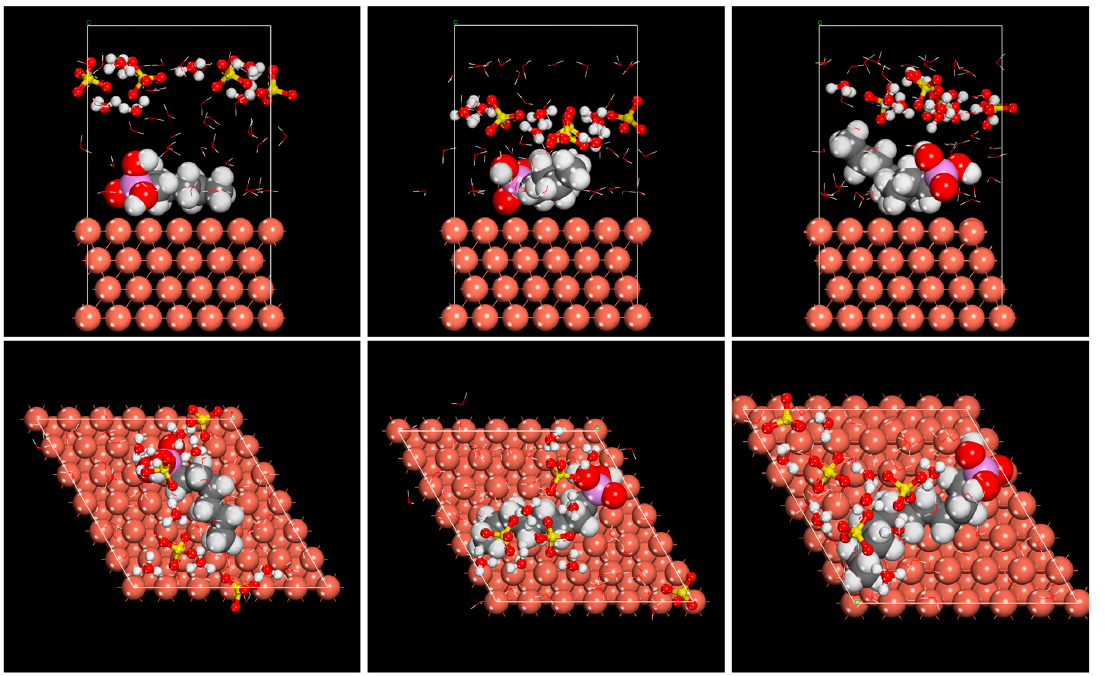
Figure 6. Top/side view of the equilibrium adsorption configuration of the alkyphosphonic acids’ adsorption onto Cu(111) surface computed in aqueous acidic media (one alkylphosphonic acid + 47 water molecules + 8 hydronium ions + 4 sulphate ions) as obtained using the Monte Carlo simulation.